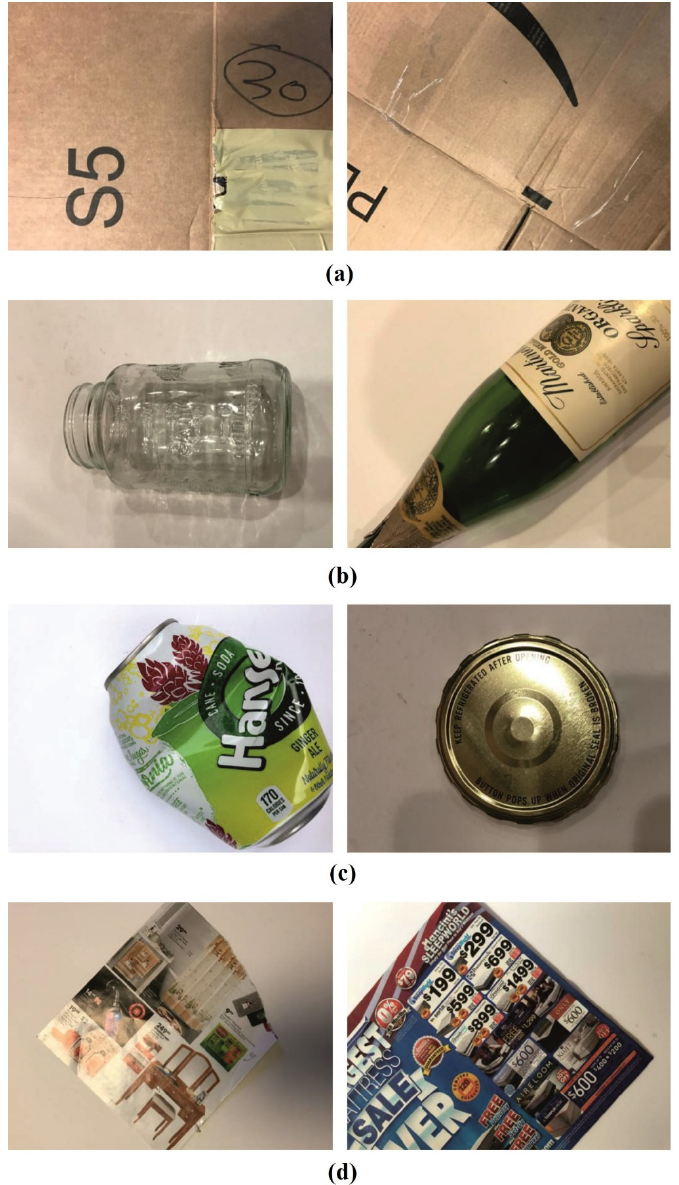
Figure 2. Sample images: ( a ) cardboard, ( b ) glass, ( c ) metal, and ( d ) paper.